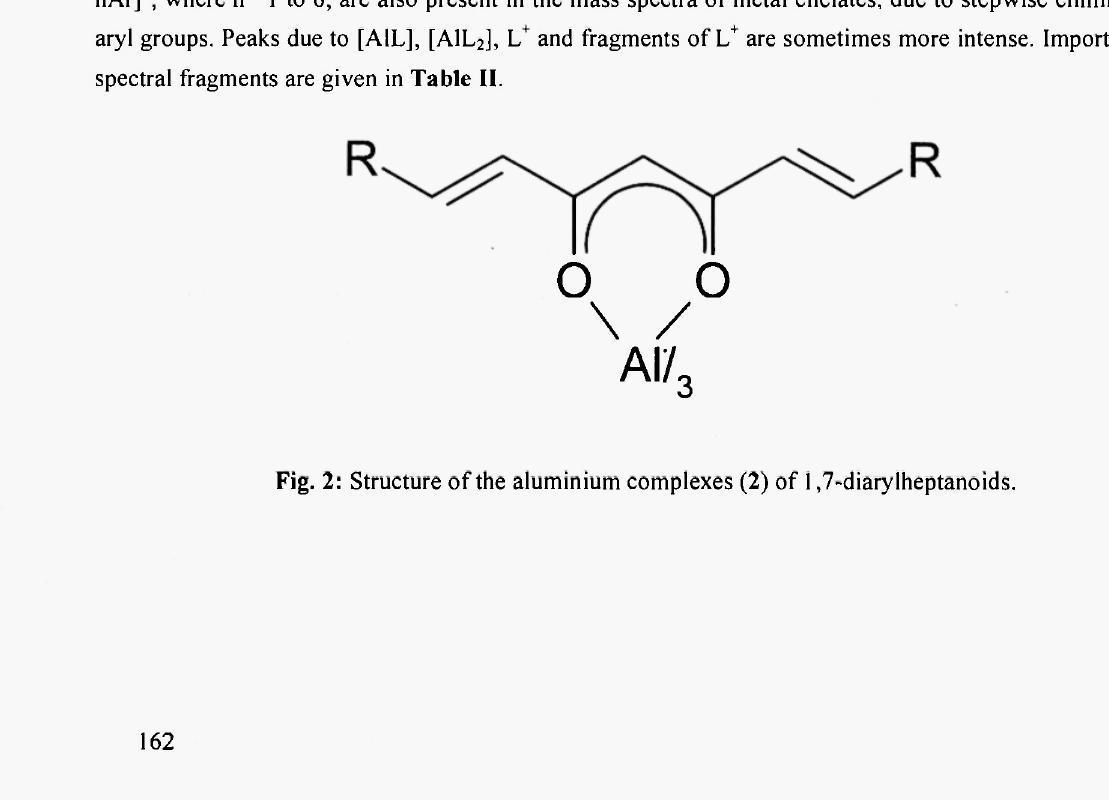
Fig. 2: Structure of the aluminium complexes (2) of 1 ,7-diarylheptanoids.